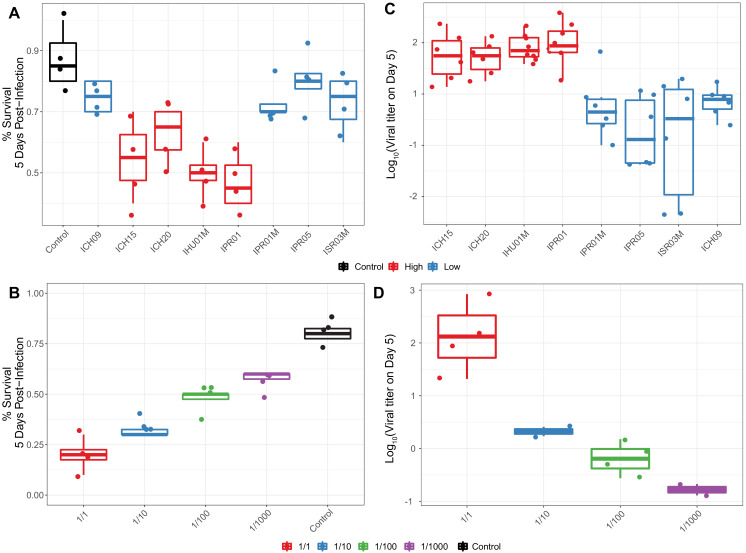
Survival of flies following infection with different titers and types of DiNV.(A) Survival of D. innubila reference strain 5 days post infection, using filtrate from different samples versus uninfected control, colored by High type virus or Low type virus. (B) Survival of D. innubila reference strain 5 days post infection using serial dilutions of IPR01 filtrate versus control. Each viral sample/dilution was used to infect 40 flies in 4 replicates of 10. (C) Viral titer estimated per viral genotype at 5 days post-infection, colored by High type virus or Low type virus. (D) Viral titer of DiNV infecting D. innubila reference strain 5 days post infection using serial dilutions of IPR01 filtrate versus control. Each sample/dilution was used to infect 40 flies in 4 replicates of 10, we then quantified the viral titer of surviving flies in groups of 5 flies, varying from 4 to 6 replicates depending on the number of surviving flies.